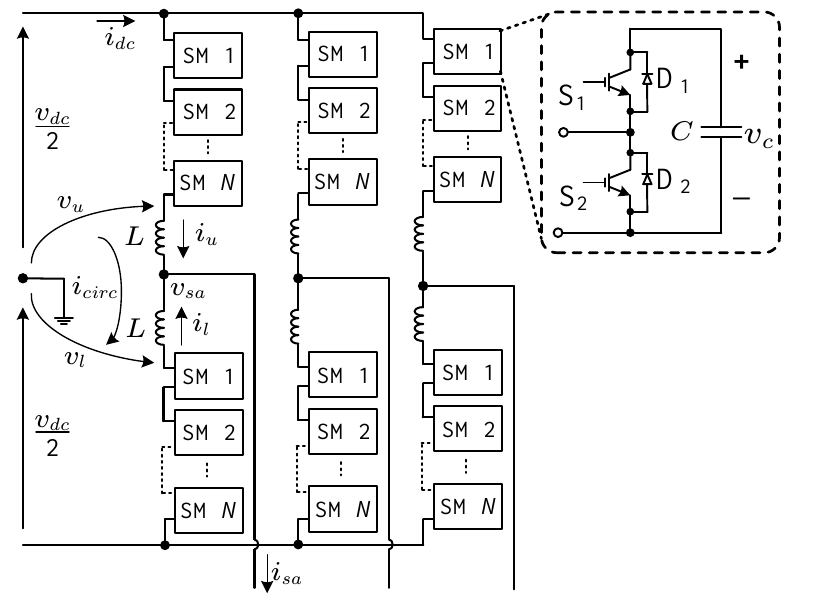
Figure 1. Circuit structure of a three-phase Modular Multilevel Converter based on half-bridge SMs. Dealing with dc-side faults is particularly important in VSC-HVDC systems,